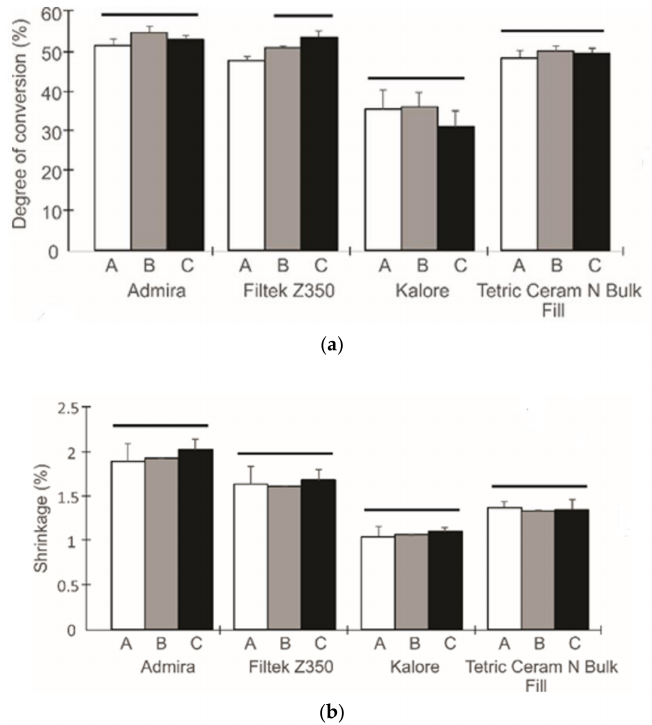
Figure 3. The degree of conversion ( a ) and the polymerization shrinkage ( b ) from different curing protocols. The columns under the same horizontal line are not statistically different.